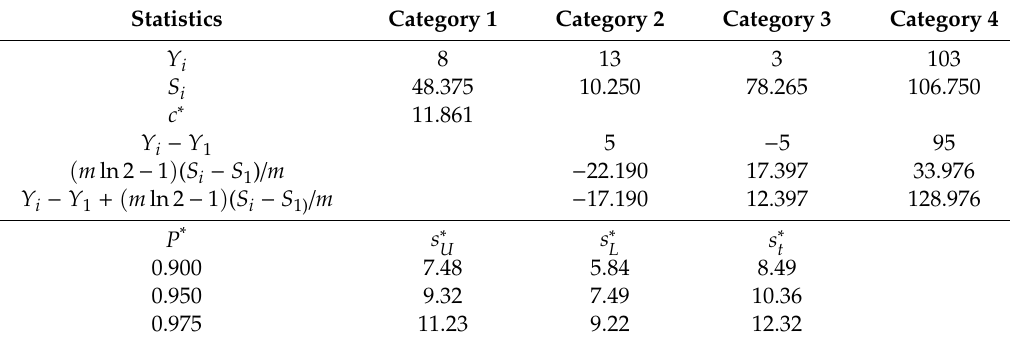
Table 3. The required statistics and critical